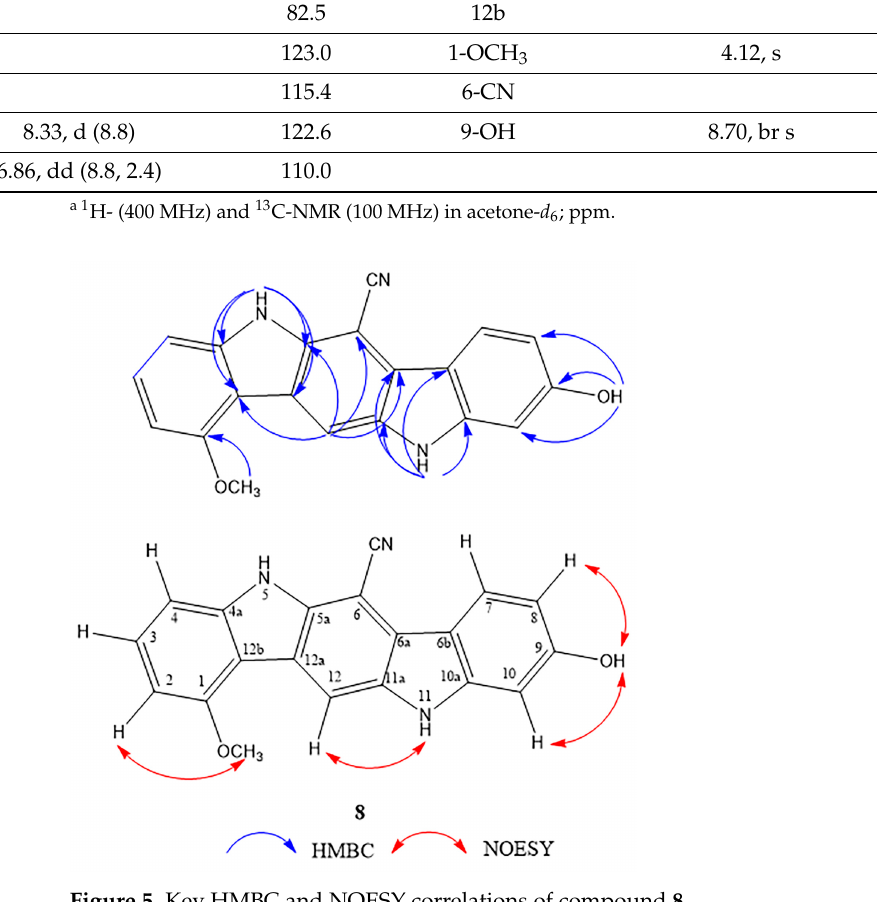
Figure 5. Key HMBC and NOESY correlations of compound 8